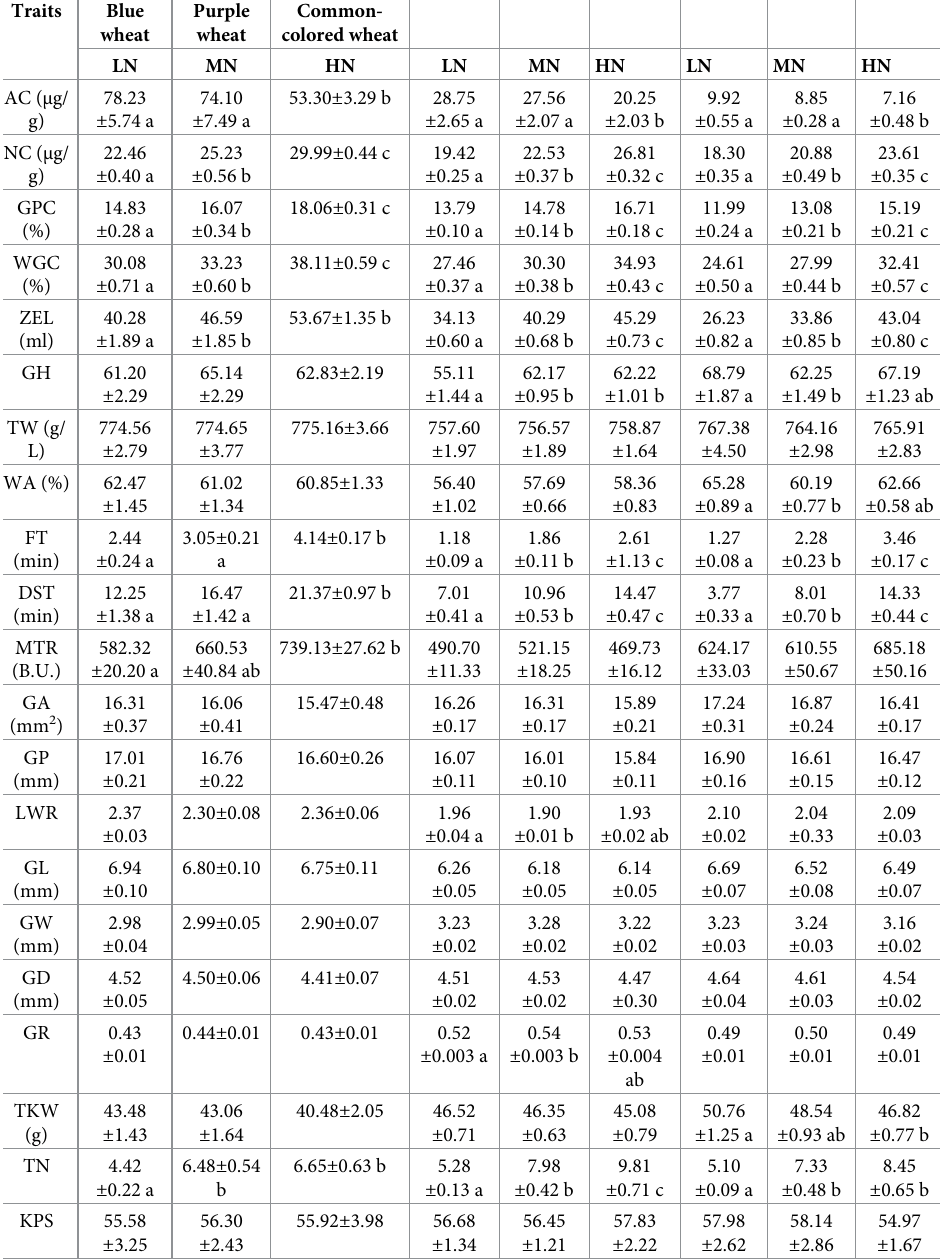
Table 3. Comparison of 21 investigated traits among different colored wheat lines under different N